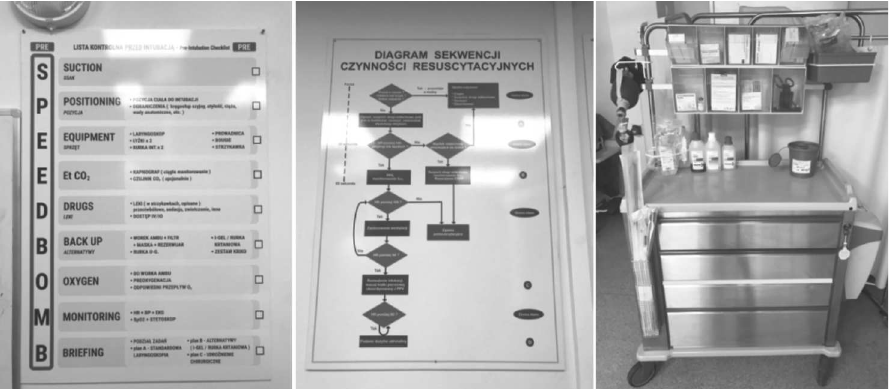
Figure 1. Examples of 5S, visual management and standardization – pre-intu- bation checklist (left), resuscitation procedure (center), organization of workstation